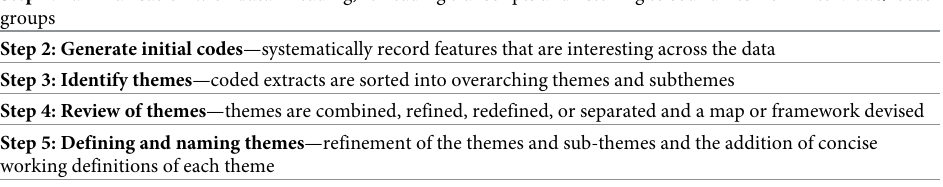
Table 1. Steps in inductive data analysis—Adapted from